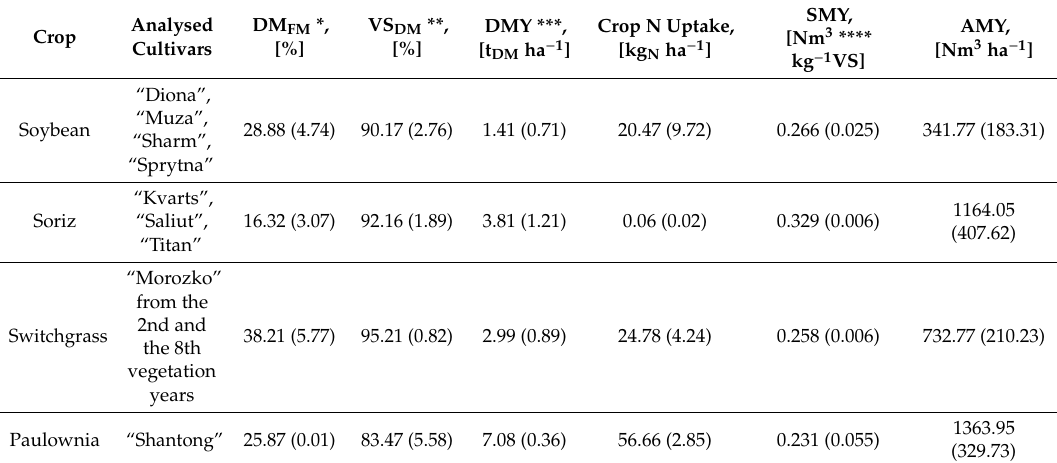
Table 6. Soybean, soriz, switchgrass and paulownia: DM and VS- content at harvest time, dry matter yield per hectare and N-uptake. Units are given in square brackets. Values are given as mean; standard deviation is given in round